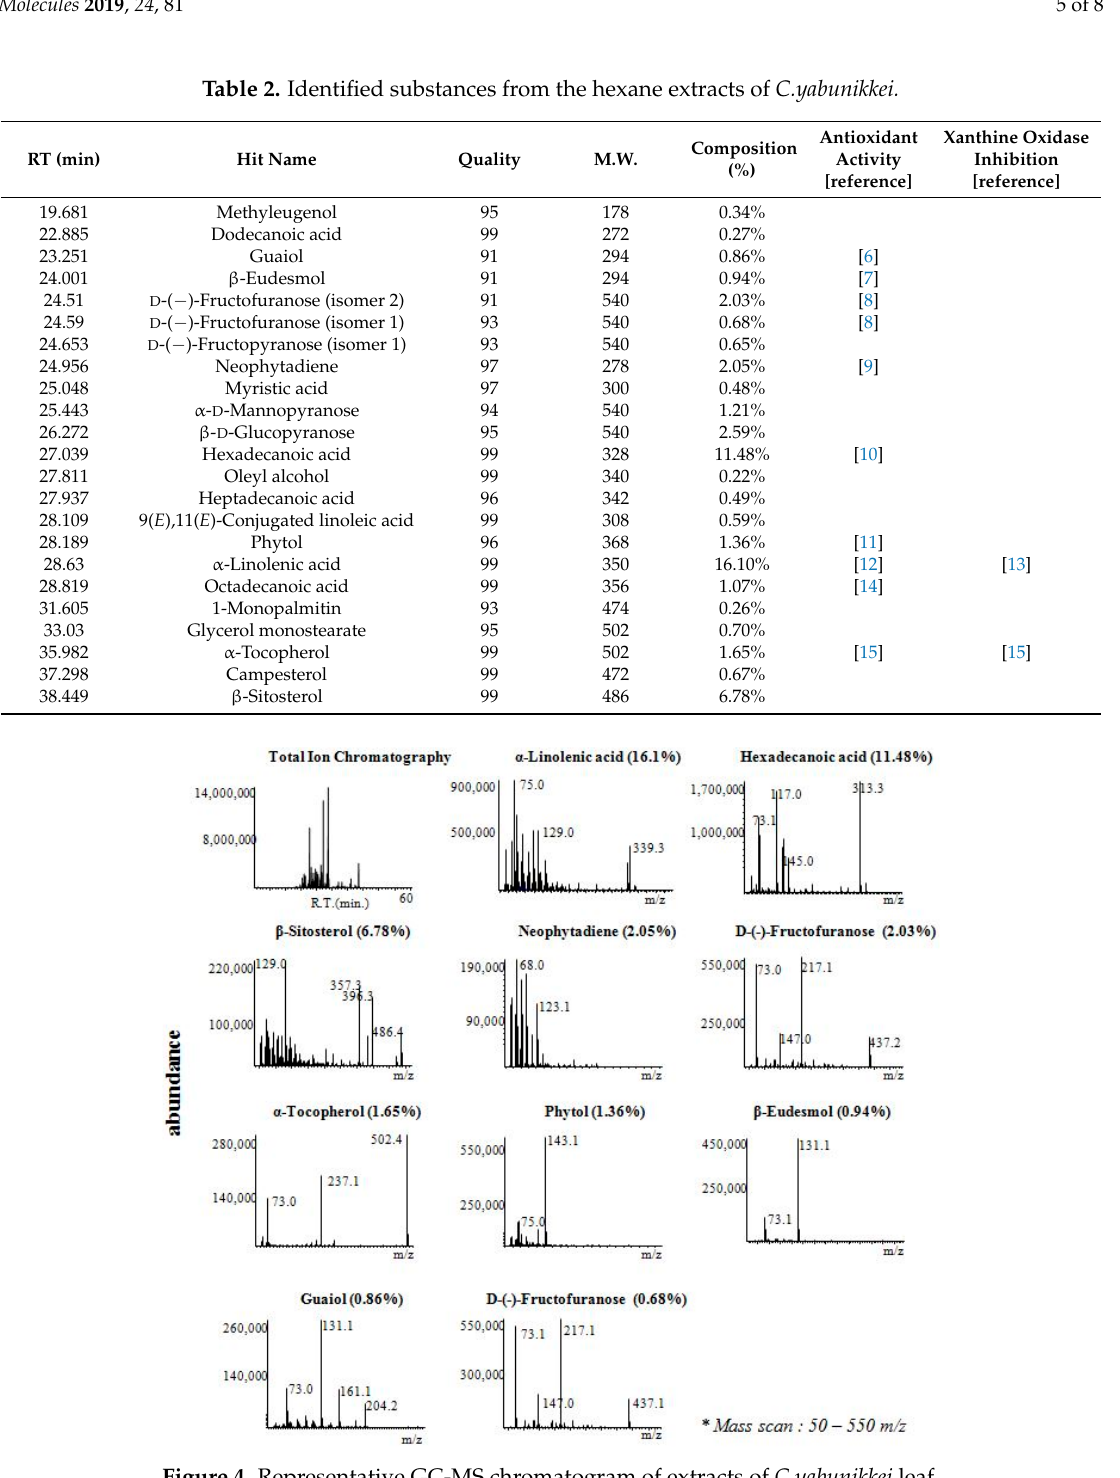
Table 2. Identified substances from the hexane extracts of C.yabunikkei.